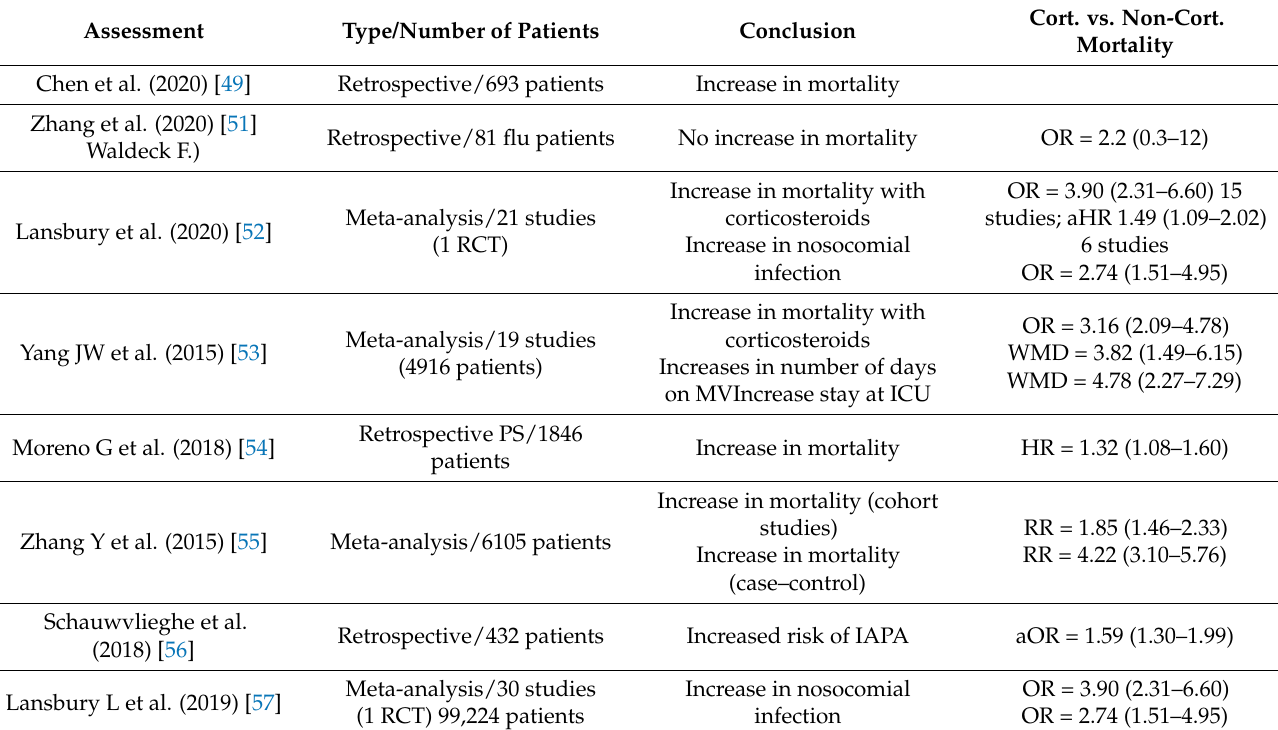
Table 4. Studies Assessing the Administration of Corticosteroids in Patients with